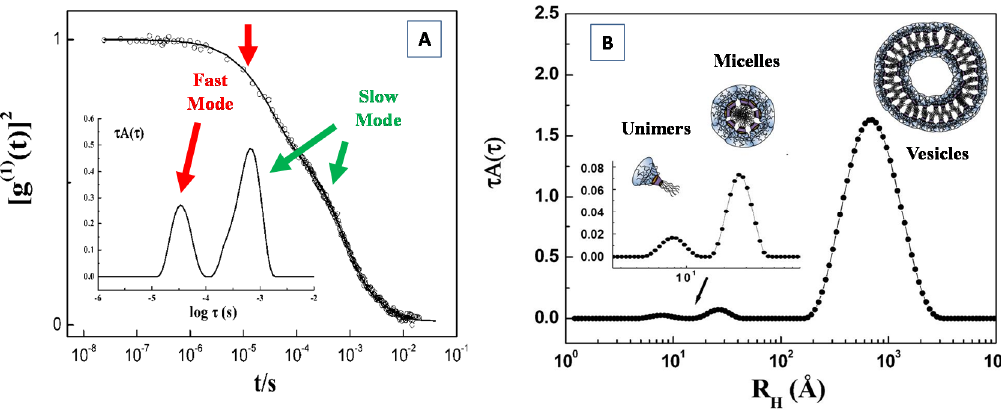
Figure 14. Example of the fit analysis of field autocorrelation function g 1 ( k , τ ) measured for a system composed of a water solution of amphiphilic modified cyclodextrin (CD). Double exponential fit of the g 1 ( k , τ ) function for the system CD4 [163] ( A ), and analysis of the relaxation time distribution τ A ( τ ) as a function of the hydrodynamic radius R H obtained by the inverse Laplace transformation with regularized positive exponential sum REPES approach (inset of A ). Triple exponential fit of the g 1 ( k , τ ) function for the system CD3 ( A ) [163], and the REPES analysis, which evidence the presence of three populations of scattering particles (namely unimers, micelles and vesicels) ( B ).